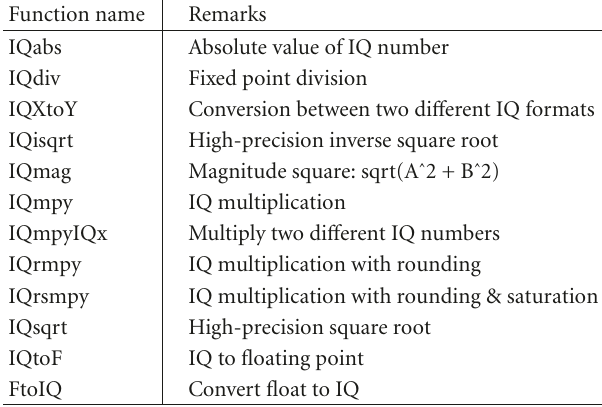
Table 2: List of relevant functions from IQmath